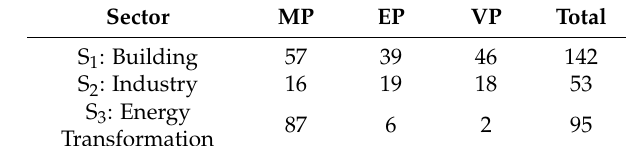
Table 13. The number of three kinds of policies adopted in four emission sectors.